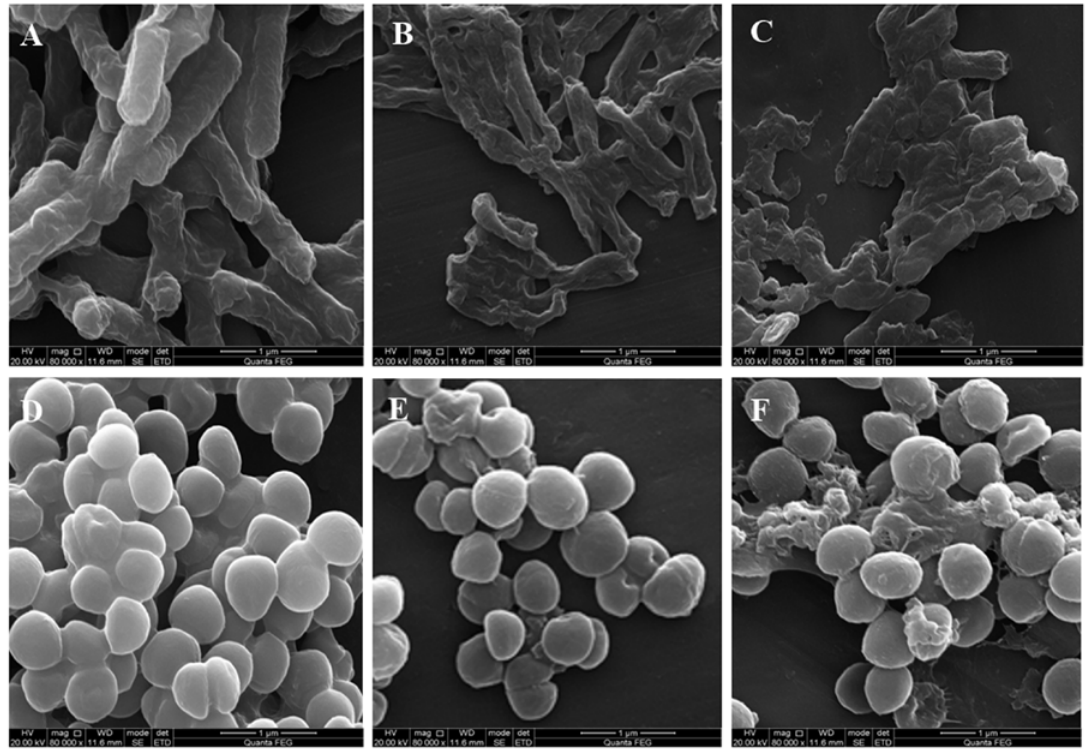
Figure 2. Scanning electron microphotographs of E. coli ( A – C ) and S. aureus ( D – F ). ( A , D ) images of untreated E. coli and S. aureus ; ( B , E ) and ( C , F ) images of E. coli and S. aureus treated with different concentrations of FEO, correspond to MIC and 2MIC.